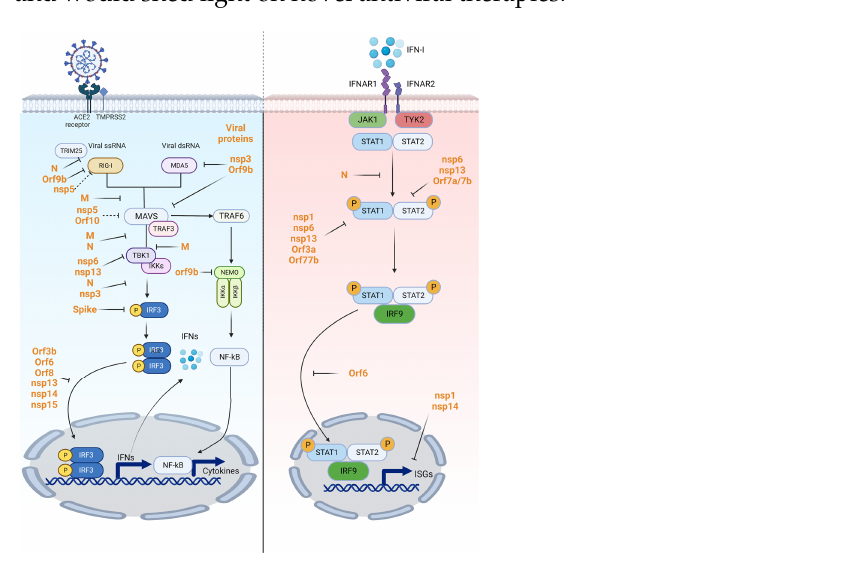
Figure 3. The role of SARS-CoV-2 proteins during antagonizing PRRs and innate immune response. Viral component recognition initiates a signaling cascade culminating in primarily type I interferon (IFN- α / β ) and inflammatory cytokine production. IFNs are secreted cytokines that activate a signal transduction cascade leading to the induction of interferon-stimulated genes (ISGs) to restrict virus replication. SARS-CoV-2 proteins can target different host targets to evade immune response at dif- ferent stages.